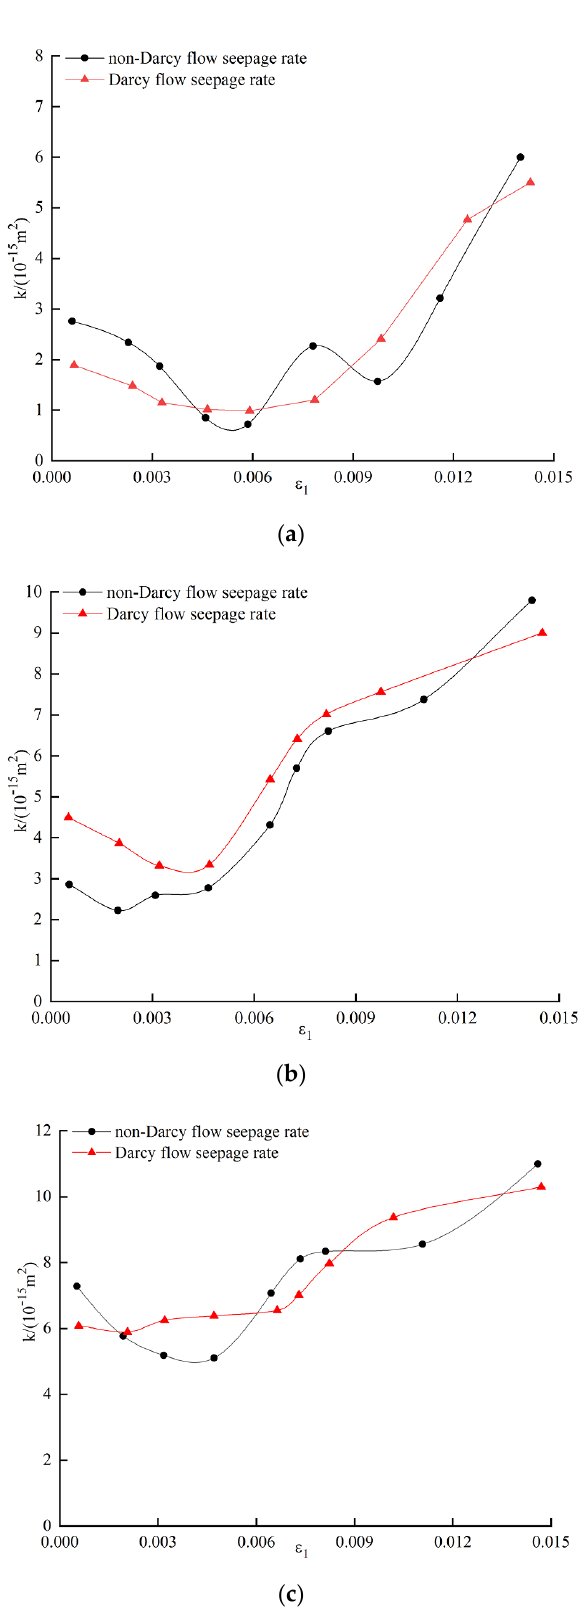
Figure 13. Comparison of permeability changes calculated based on Darcy and non-Darcy flow under di ff erent seepage pressures. ( a ) Pore pressure 1 MPa; ( b ) pore pressure 4 MPa; ( c ) pore pressure 7